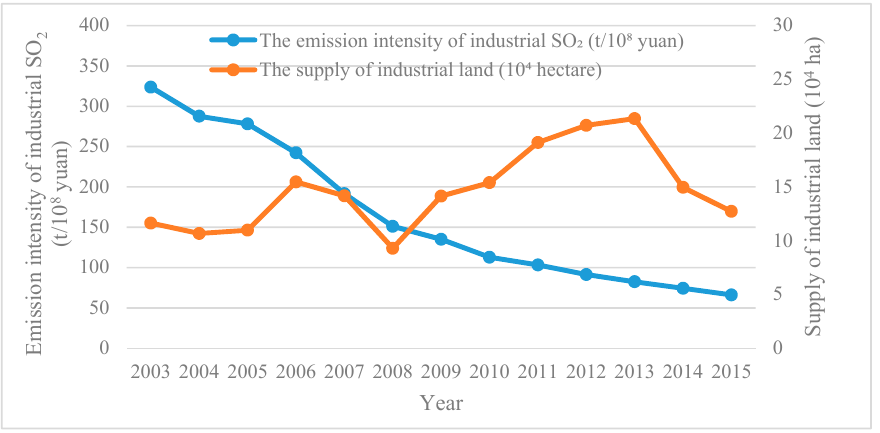
Figure 3. The change in China’s industrial land supply area and industrial pollution from 2003 to 2015.